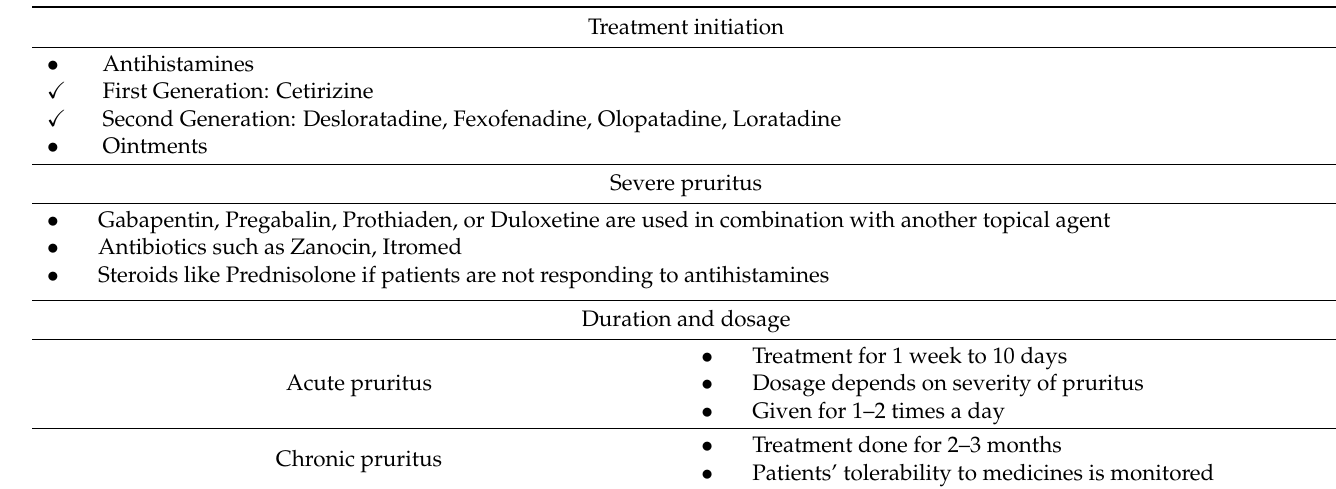
Table 1. Treatment prescribed, duration, and dosage of